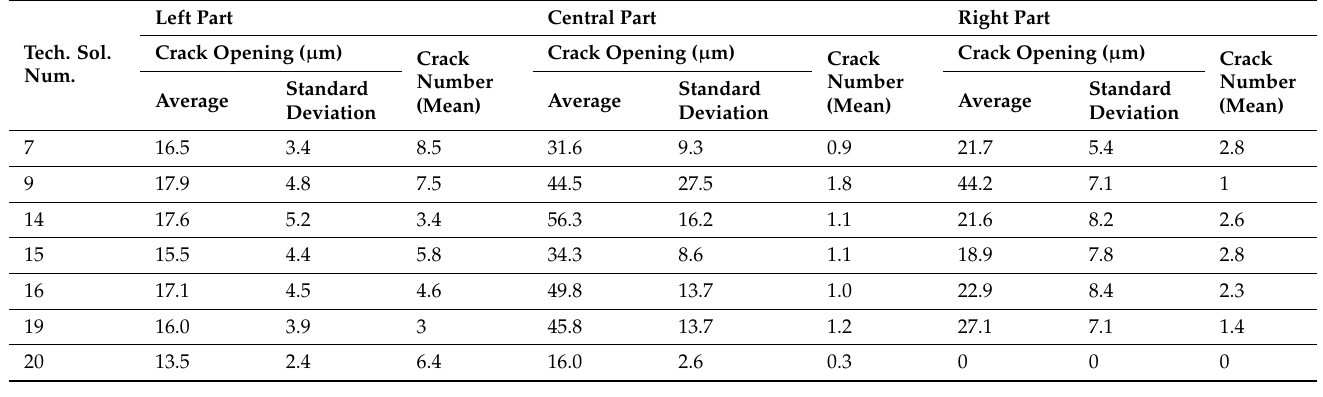
Table 2. Results related to the acceptable technical solutions.